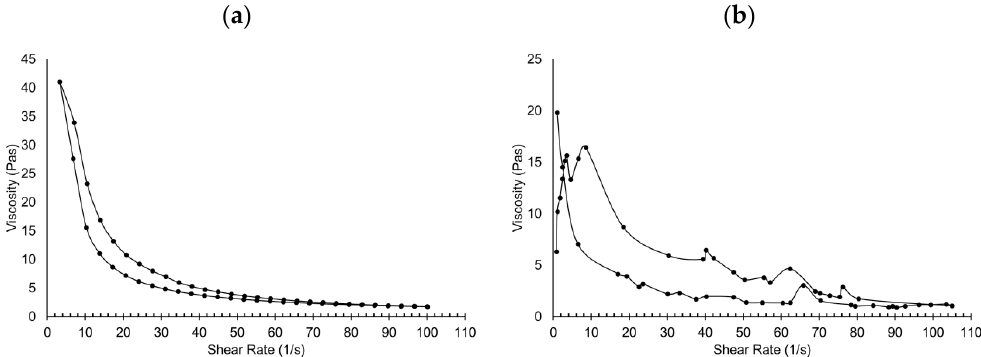
Figure 3. Rheology profile of 2.5% w/v iota-carrageenan gel, ( a ) without CBZ-alginate beads, ( b ) with CBZ-alginate beads.